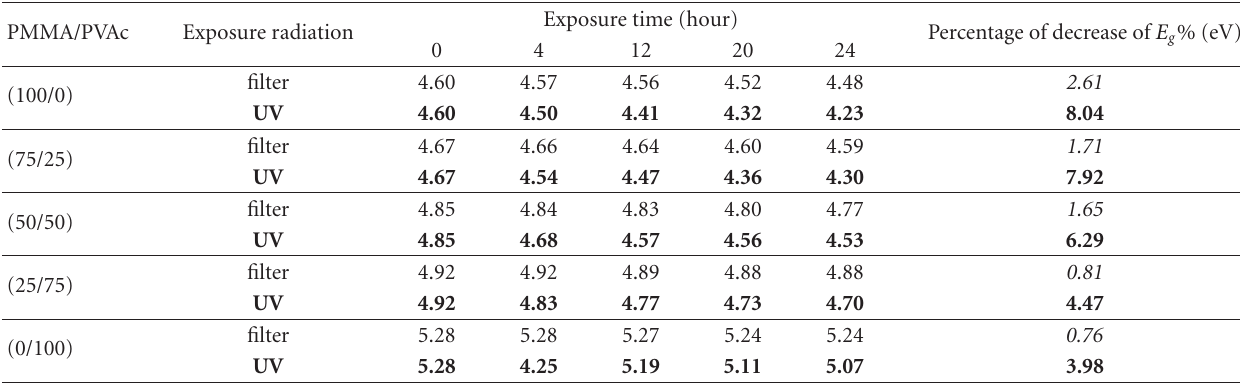
Table 1: The energy gap E g (eV) for di ff erent concentrations of (PMMA/PVAc) blend after exposure to UV and filtered radiation at di ff erent exposure times.